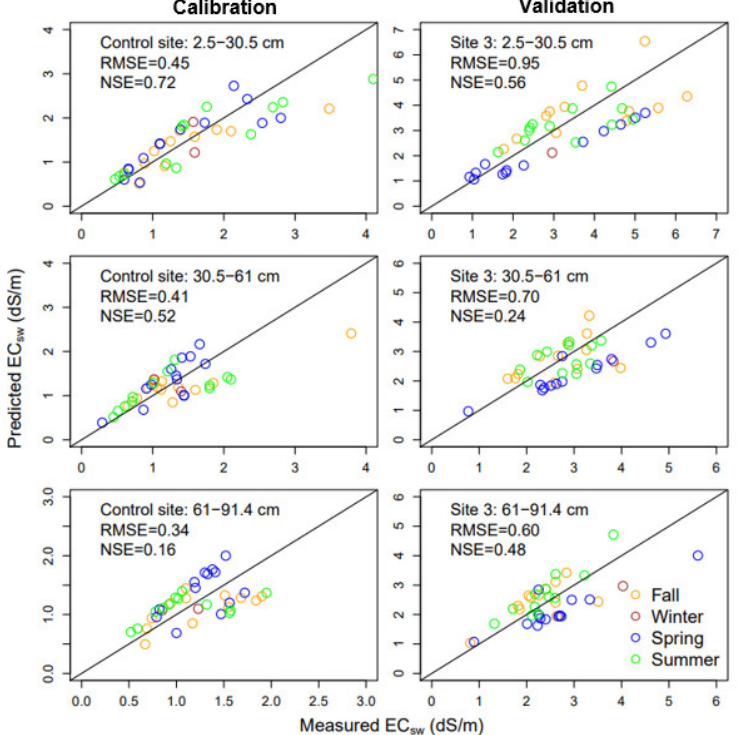
Figure 7. Predicted vs. measured EC sw at 2.5–30.5 cm, 30.5–61 cm and 61–91.4 cm soil depths for control site (calibration) and site 3 (validation).